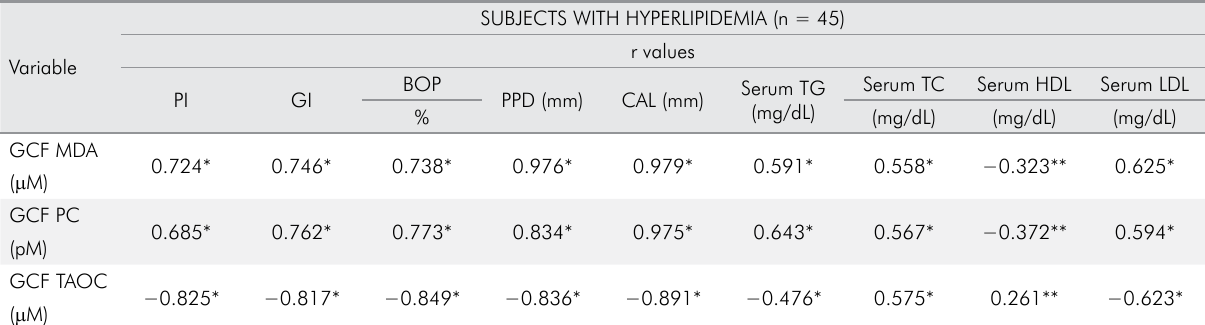
Table 5. Correlations between periodontal clinical measurements and biochemical parameters in subjects with hyperlipidemia. SUBJECTS WITH HYPERLIPIDEMIA (n = 45) Variable